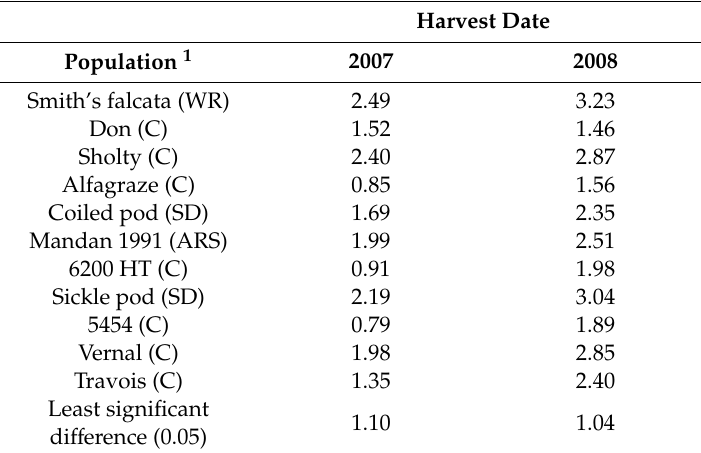
Table 3. Dry matter forage production (Mg ha − 1 ) of eight cultivars and three experimental populations of alfalfa harvested on 24 July in each of 2007 and 2008 at Brookings, South Dakota.